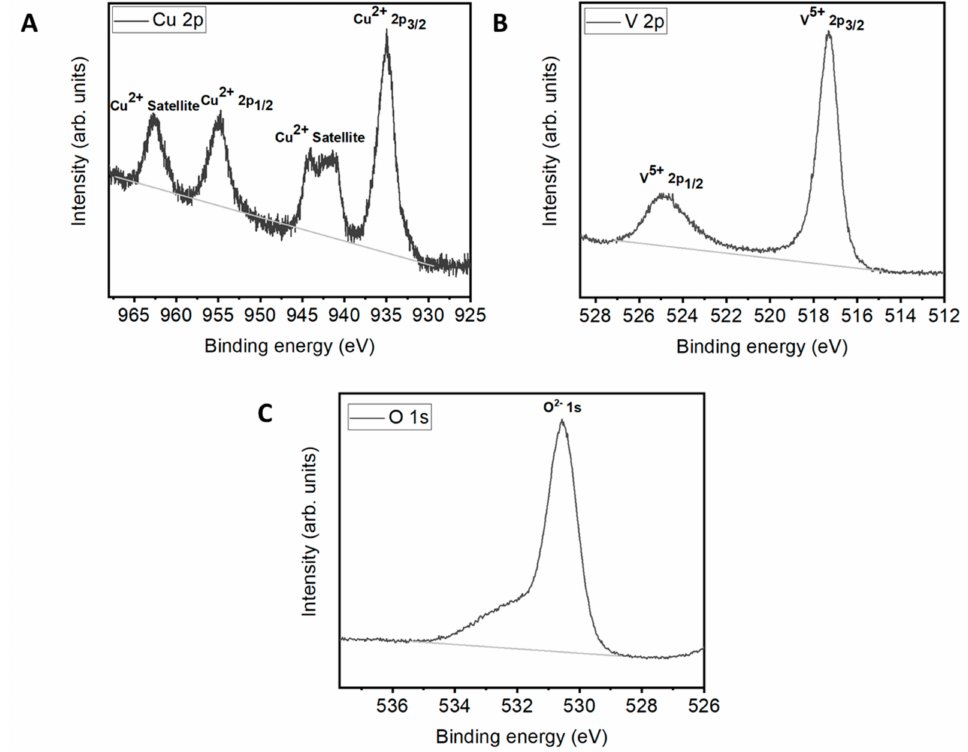
Figure 4. XPS spectra of Cu-VO ( A ) Cu, ( B ) V, and ( C ) O. XPS spectra showed the peaks for 2p 3/2 and 2p 1/2 orbitals of Cu 2+ and V 5+ and 1s orbital of O 2 − . The UV–Vis/NIR spectrum of Cu-VO was shown in Figure 5A. Cu-VO showed the broad absorption spectrum from the UV region to the visible region (~200 to ~600 nm) [33]. The broad absorption spectrum indicated that the Cu-VO could have excellent solar-energy- harvesting capacity. The direct and indirect band gaps of Cu-VO were calculated using Tauc’s plot (Figure 5B). Cu-VO had one indirect band gap of ~1.84 eV and two direct band gaps of 1.18 and 3.2 eV. The band gap values of Cu-VO revealed that Cu-VO could be a good solar light-active photocatalyst. The results are in good agreement with the photocatalytic activity of Cu-VO obtained against M. aeruginosa and MB, as discussed